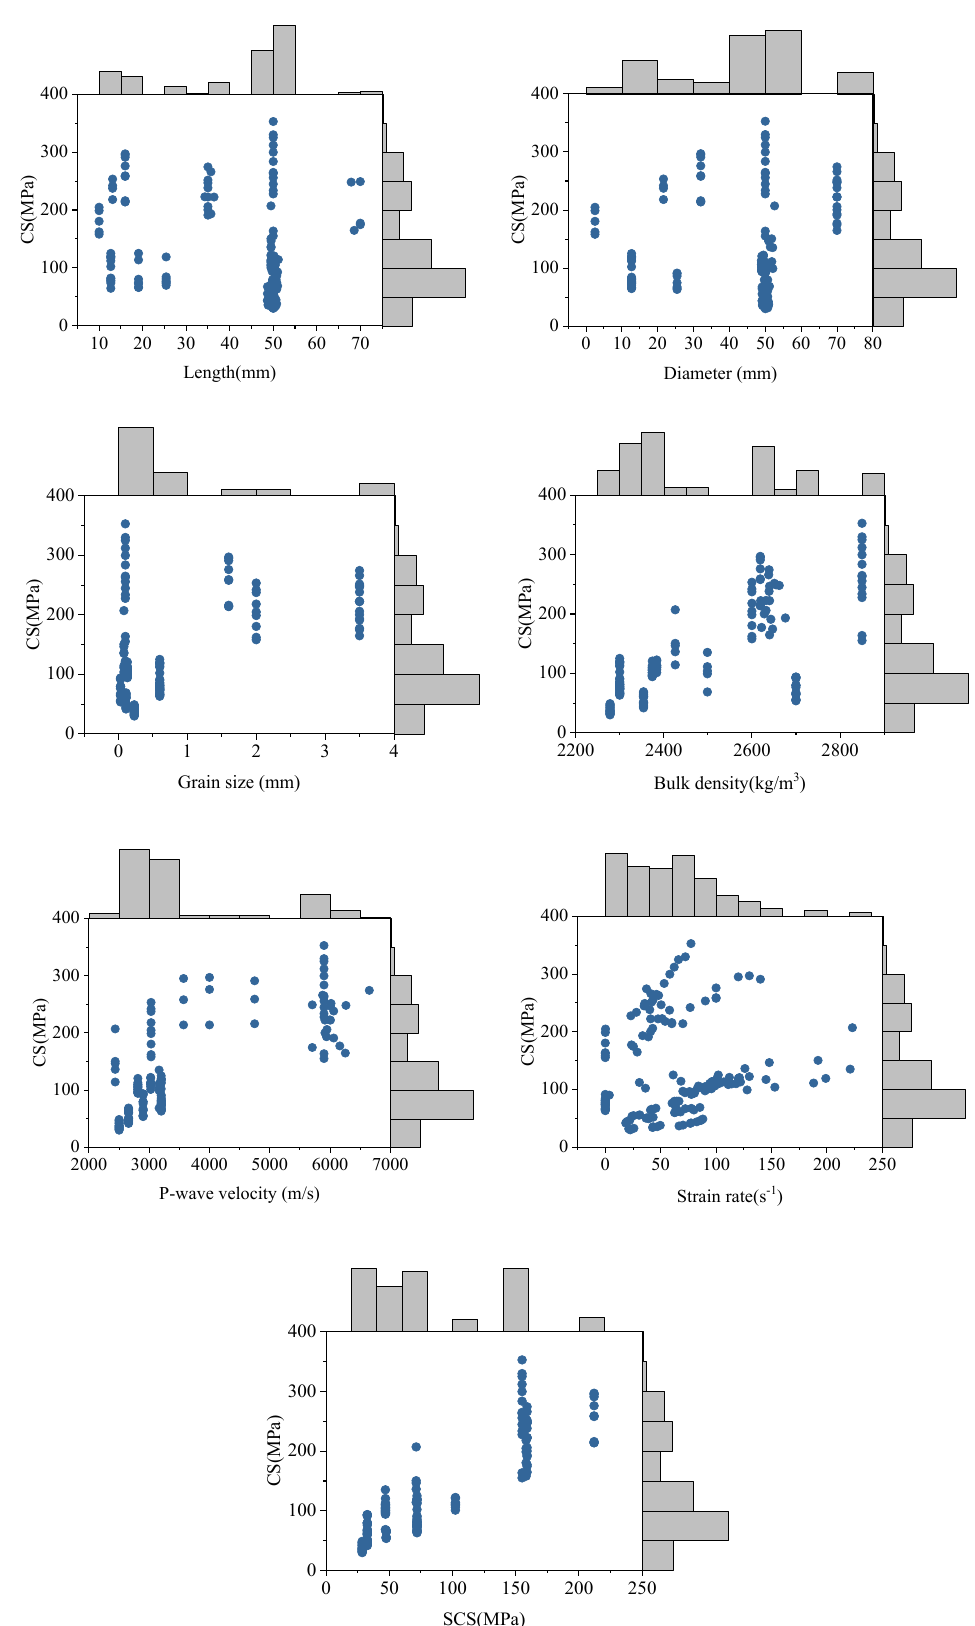
Figure 4. Scatterplot and histogram of the distribution of the input and output parameters. Table 1. Distribution characteristics of the parameters.